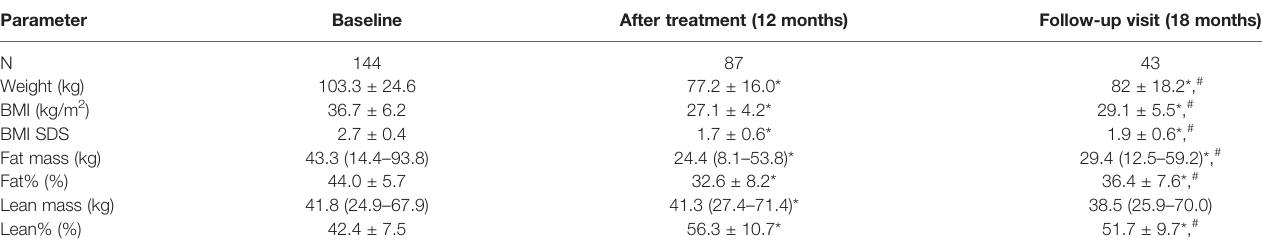
TABLE 2 | Evolution of anthropometric and body composition parameters during and after treatment. Parameter Baseline After treatment (12